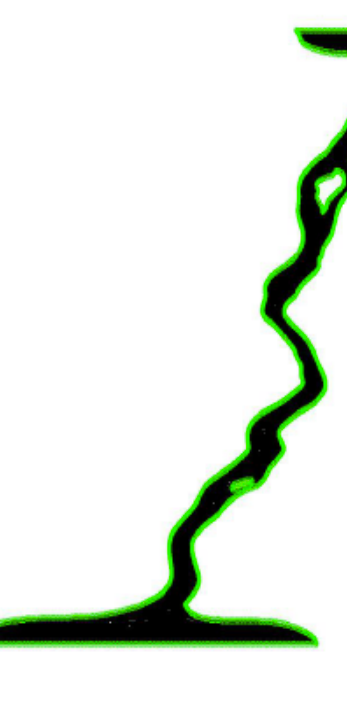
Figure 10. Stress distribution (Shields stress values) in the St. Clair River under average flow conditions. There are three regions of elevated stresses on the bed (yellow and red